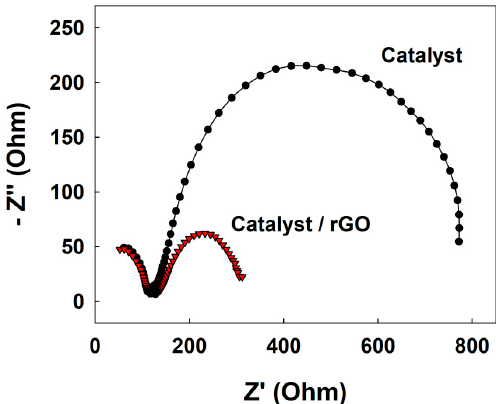
Figure 4. Nyquist plots of the catalyst-modified (black) and the catalyst/rGO composite-modified (red) GCEs recorded in O 2 -saturated 0.1 M KOH electrolyte solution.